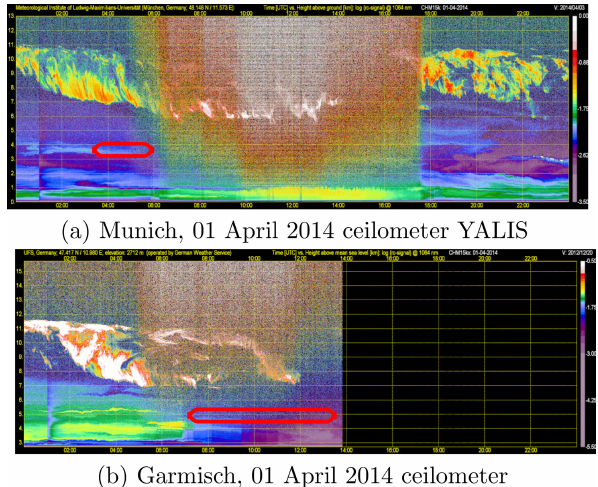
Figure 7. Logarithm of the range-corrected signal at 1064nm, 24h, for the Munich (a) and Garmisch (b) stations. The red boxes repre- sent the identified layers.